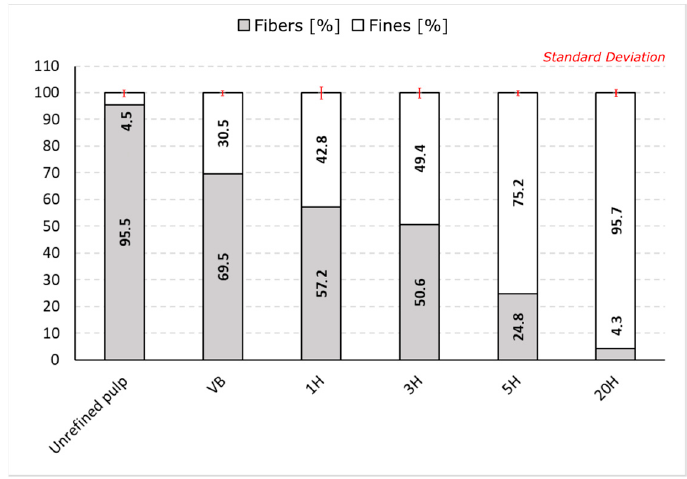
Figure 4. Fibers (white area) and Fines (grey area) fractions measured for the high-pressure homogenized samples (3 samples tested), using Britt Jar system.